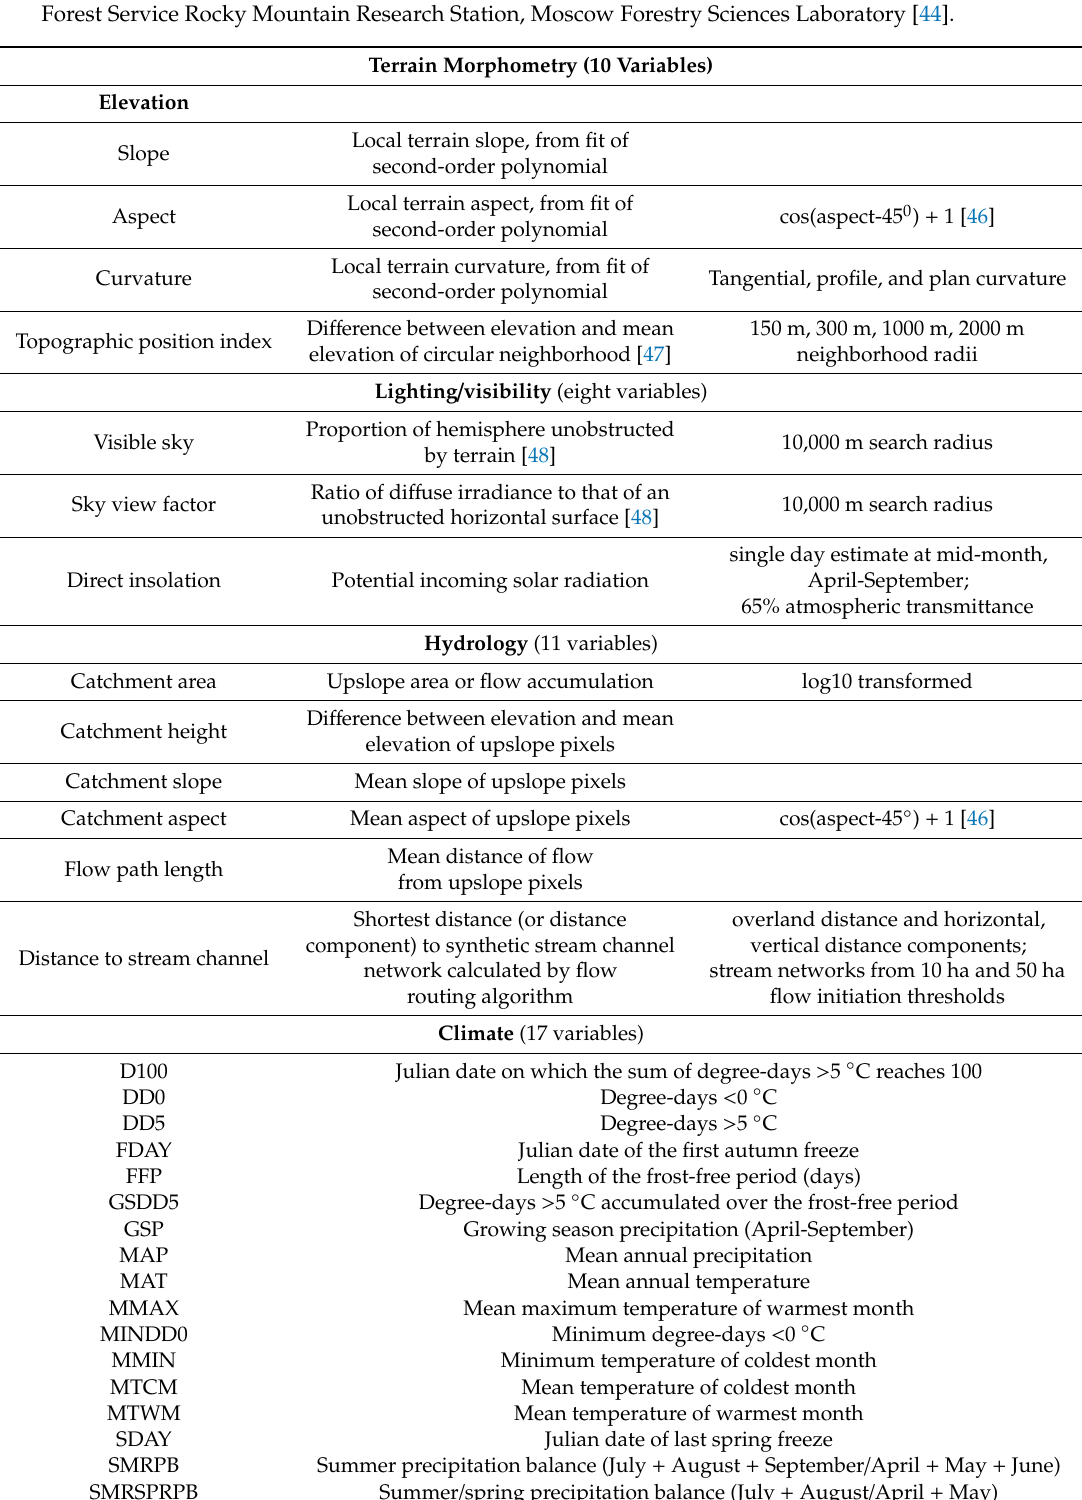
Table 2. Terrain and climate variables used to model and map tree species relative abundance. Terrain variables were calculated using the System for Automated Geoscientific Analyses software [39] v. 2.1.4 with default settings unless otherwise specified. Climate variables were obtained from the USDA Forest Service Rocky Mountain Research Station, Moscow Forestry Sciences Laboratory